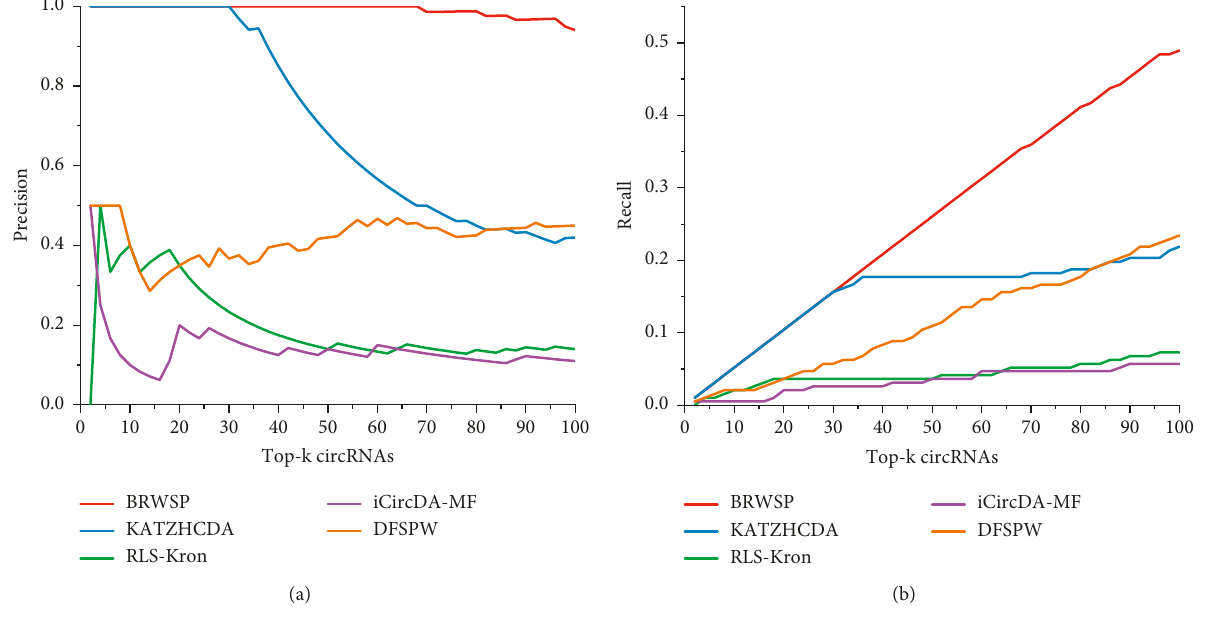
Figure 6: The precision and recall at top-k circRNAs.